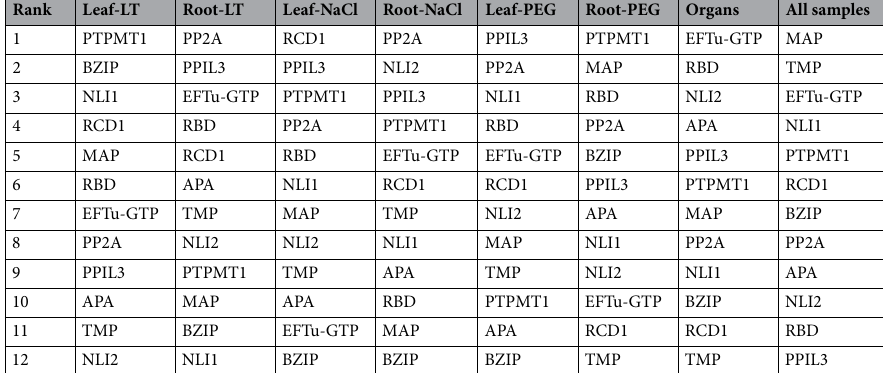
Table 2. Ranking of 12 candidate reference genes according to NormFinder.